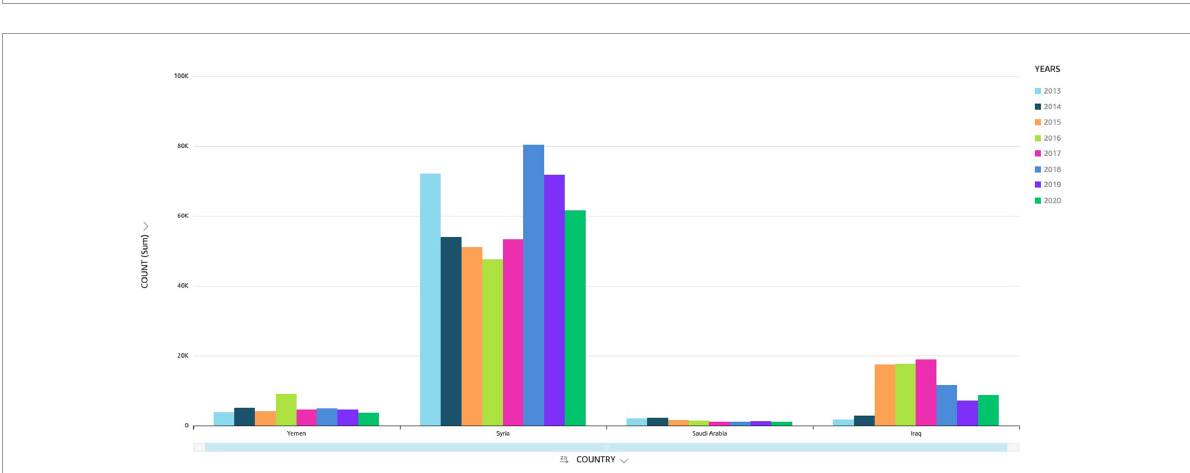
FIGURE1 Number of visceral leishmaniasis cases reported in Saudi Arabia (1991–2021).